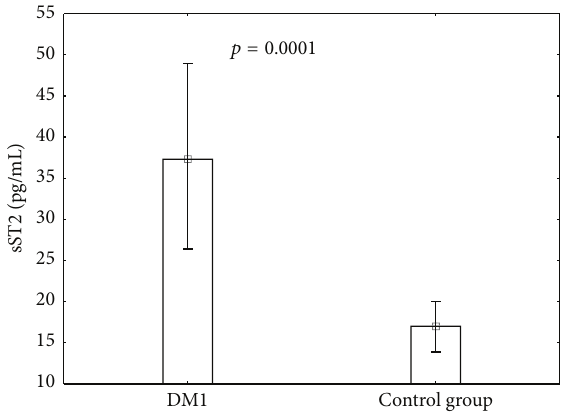
Tregs after in vitro treatment with IL-33 in DM1 patients and control group. PBMCs from 16 patients with type 1 diabetes and 8 healthy individuals were stimulated as described in Material and Methods and stained with specific antibodies against Treg associated molecules. During the cytometric analysis, the frequency of CD 4 + CD 25 high FOXP 3 + was determined. Data were calculated with the nonparametric Wilcoxon test. Horizontal lines represent the mean frequency of cells. DM1: group of patients with type 1 diabetes; C: control group of healthy individuals.